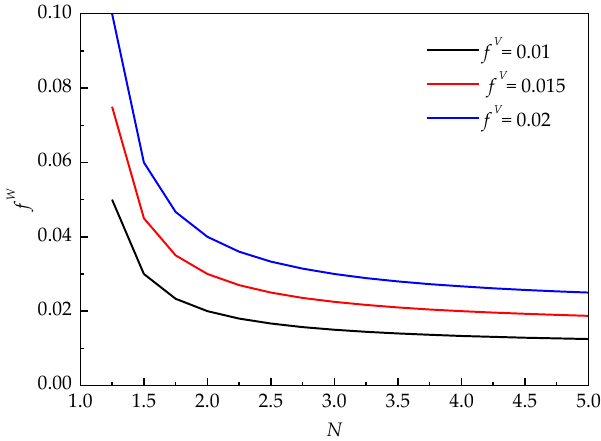
Figure 2. The relationship between f W and N . Figure 2 . The relationship between f W and N. Figure 2 . The relationship between f W and N.